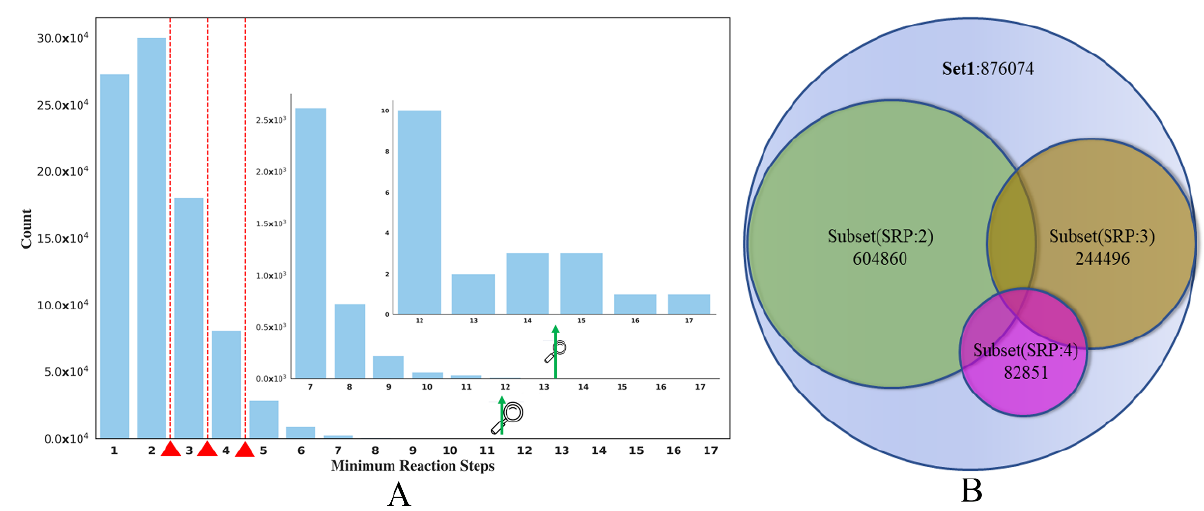
Figure 8. ( A ) The distribution of the SET1. ( B ) Splitting of SET1 dataset into three independent subsets (SRP:2, SRP:3, SPR:4).